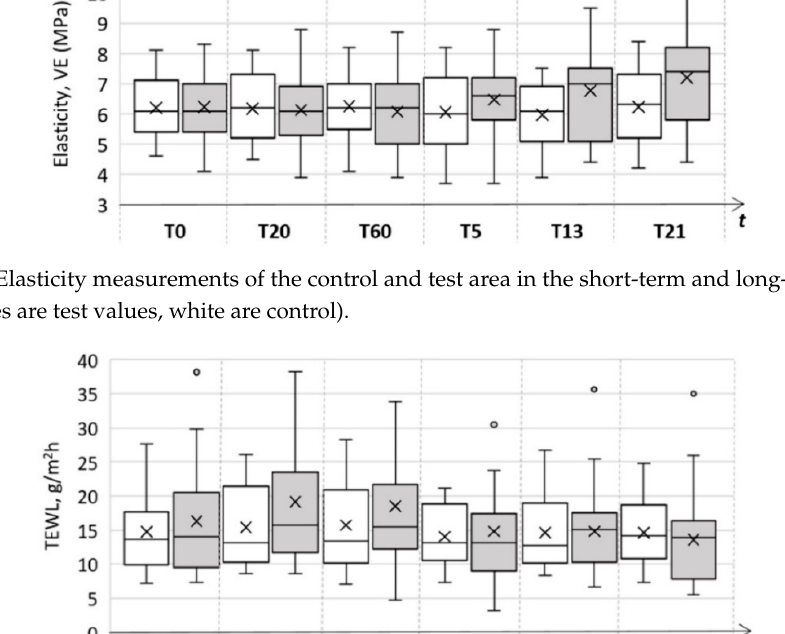
Figure 2. Hydration measurements of the control and test area in the short-term and long-term study (grey boxes are test values, white are control).